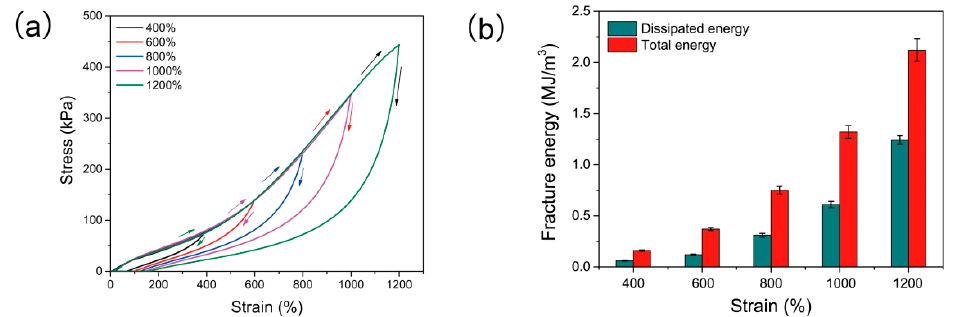
Figure 4. ( a ) Loading–unloading profiles of PAS gels with different strains; ( b ) total fracture energy and dissipated fracture energy calculated from ( a ).